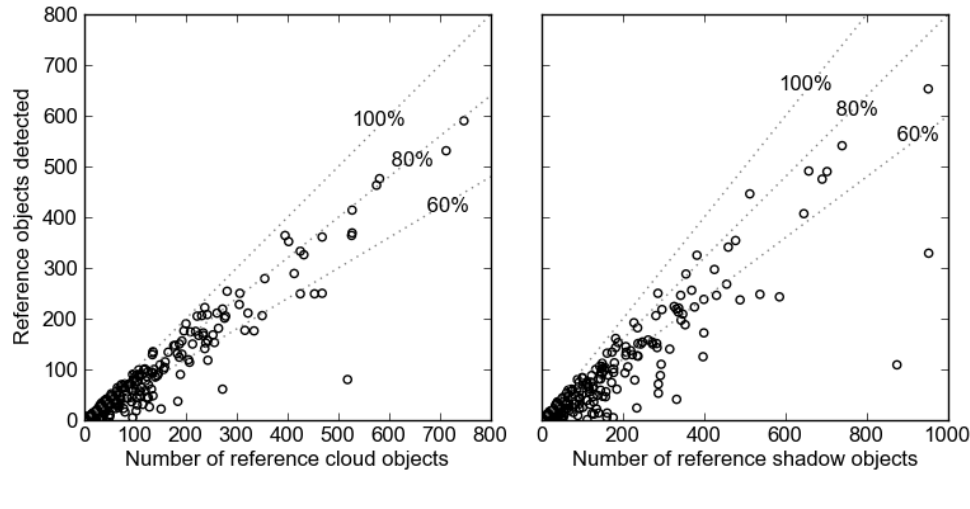
Figure 13. The number of reference cloud and shadow objects detected in the 313 training/validation images. A reference object, defined as a 4-connected group of pixels, was classed as detected if it contained at least one classified pixel. Dashed lines represent 60%, 80% and 100% object producers